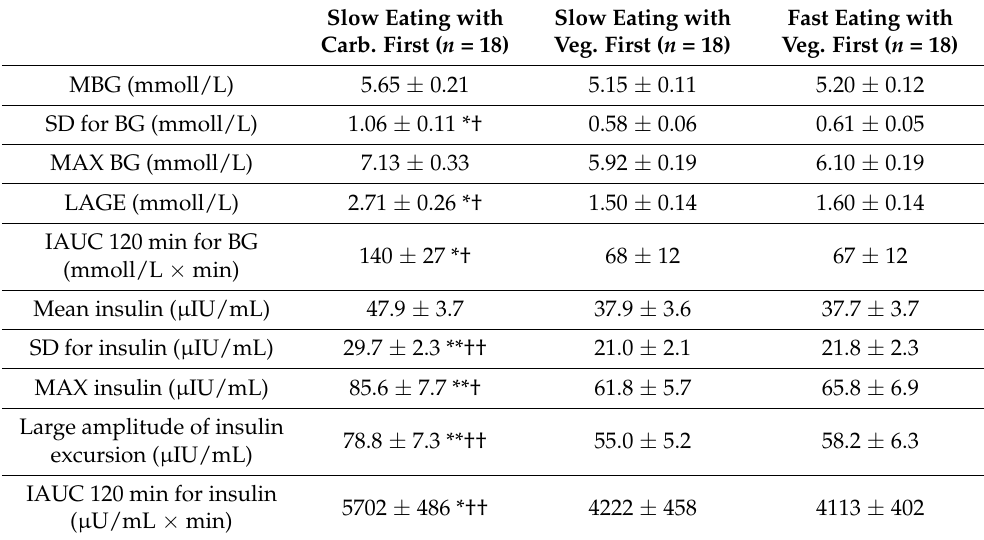
Table 2. Blood glucose and insulin parameters of different speeds with different food orders in young, healthy women. Slow Eating with Carb. First ( n =